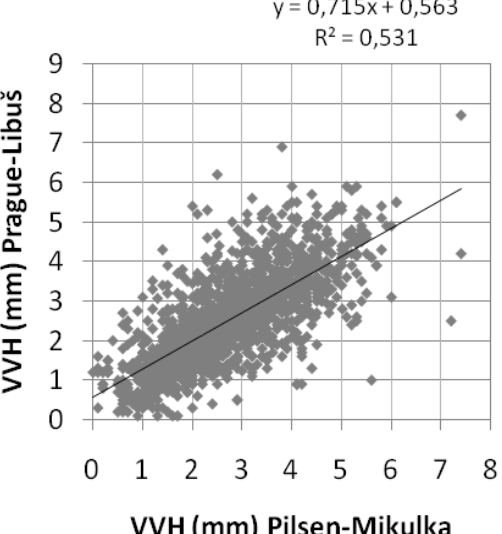
Fig. 10. Relationship between daily evaporation amount from water surface at the stations in Prague-Libuš and Pilsen- Mikulka